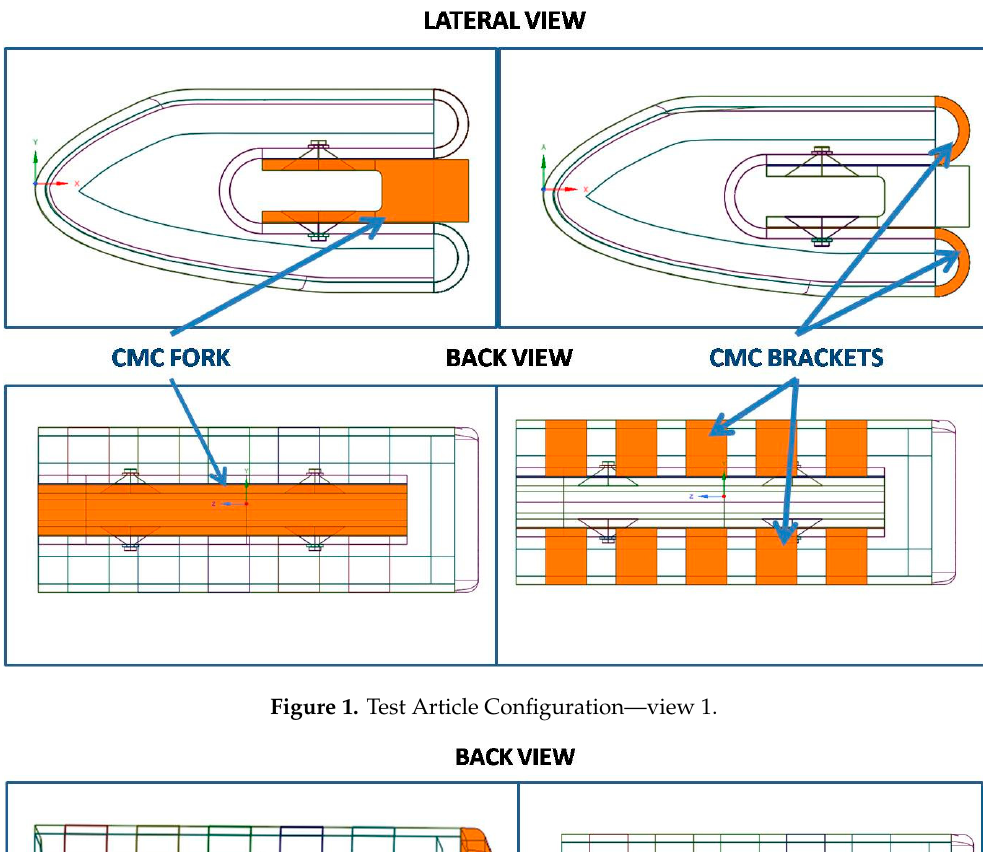
Figure 1. Test Article Configuration – view 1.